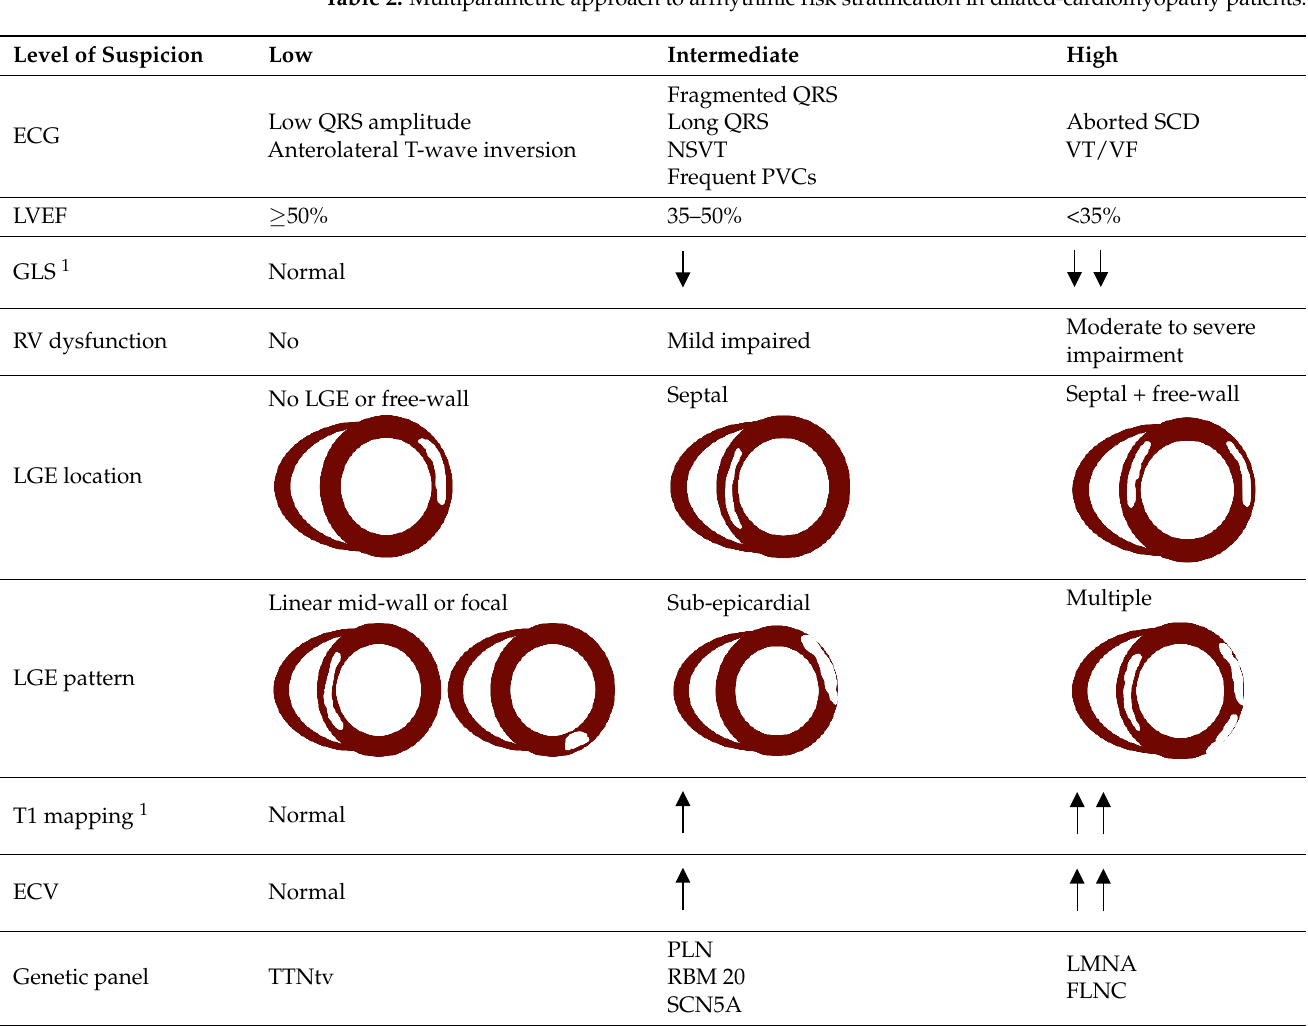
Table 2. Multiparametric approach to arrhythmic risk stratification in dilated-cardiomyopathy pa- tients.